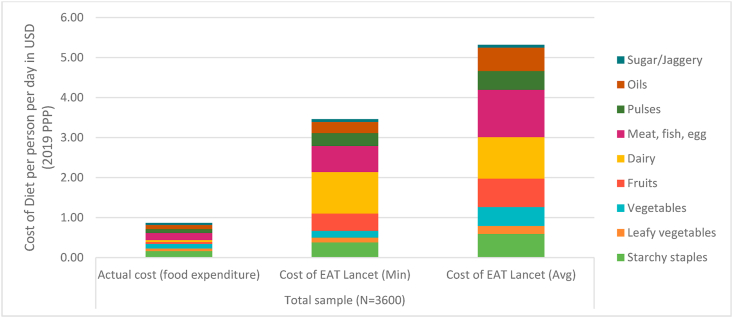
Cost of diet estimates for actual and recommended diets in rural India, May 2019.